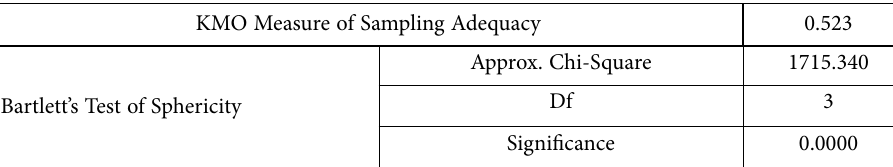
Table 3. Eigenvalues of the principal components (source: own computations using EViews 10) PCA Period: 1995 2016 Observations: 594 Computed using: Ordinary